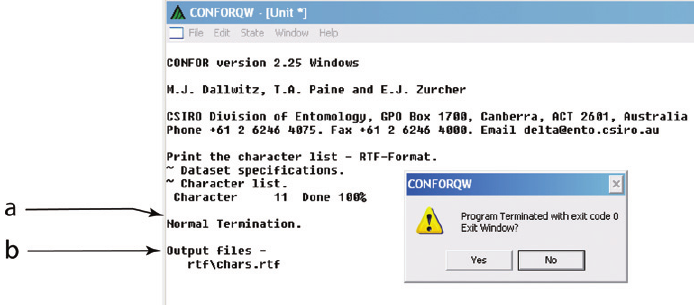
Figure 27a–b. Information window of Confor informing the user of a successful output: a it was termi- nated correctly and b the path shows were the output fi les are